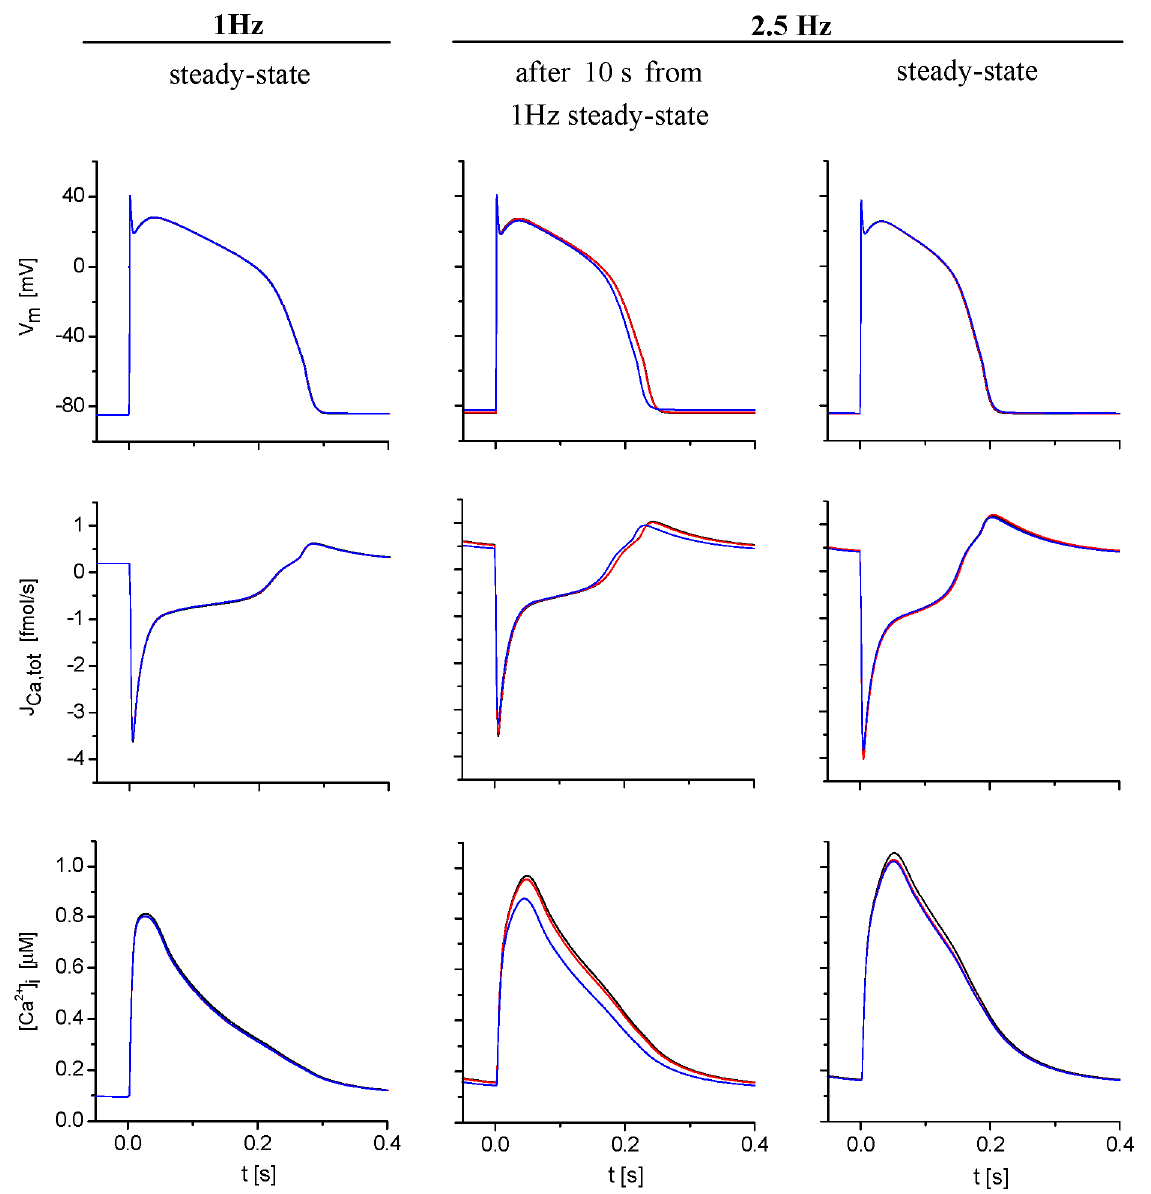
Figure 6. The effect of ion concentration changes in extracellular spaces on the action potential (AP) ( V ), total sarcolemmal Ca 2+ flux ( J ) and cytosolic Ca 2+ -transient after a m Ca,tot sudden increase of stimulation frequency from 1 to 2.5 Hz. The left, middle and right columns show the results obtained, respectively, at 1 Hz steady-state stimulation, at 10 and at 600 s (steady state) after a sudden increase of simulation rate to 2.5 Hz. The model was run when t-tubular and cleft ion concentrations were allowed to change (blue lines), when ion concentrations in the cleft space were fixed (red lines) and when both t-tubular and cleft ion concentrations were fixed at external bulk levels (black, practically identical to red